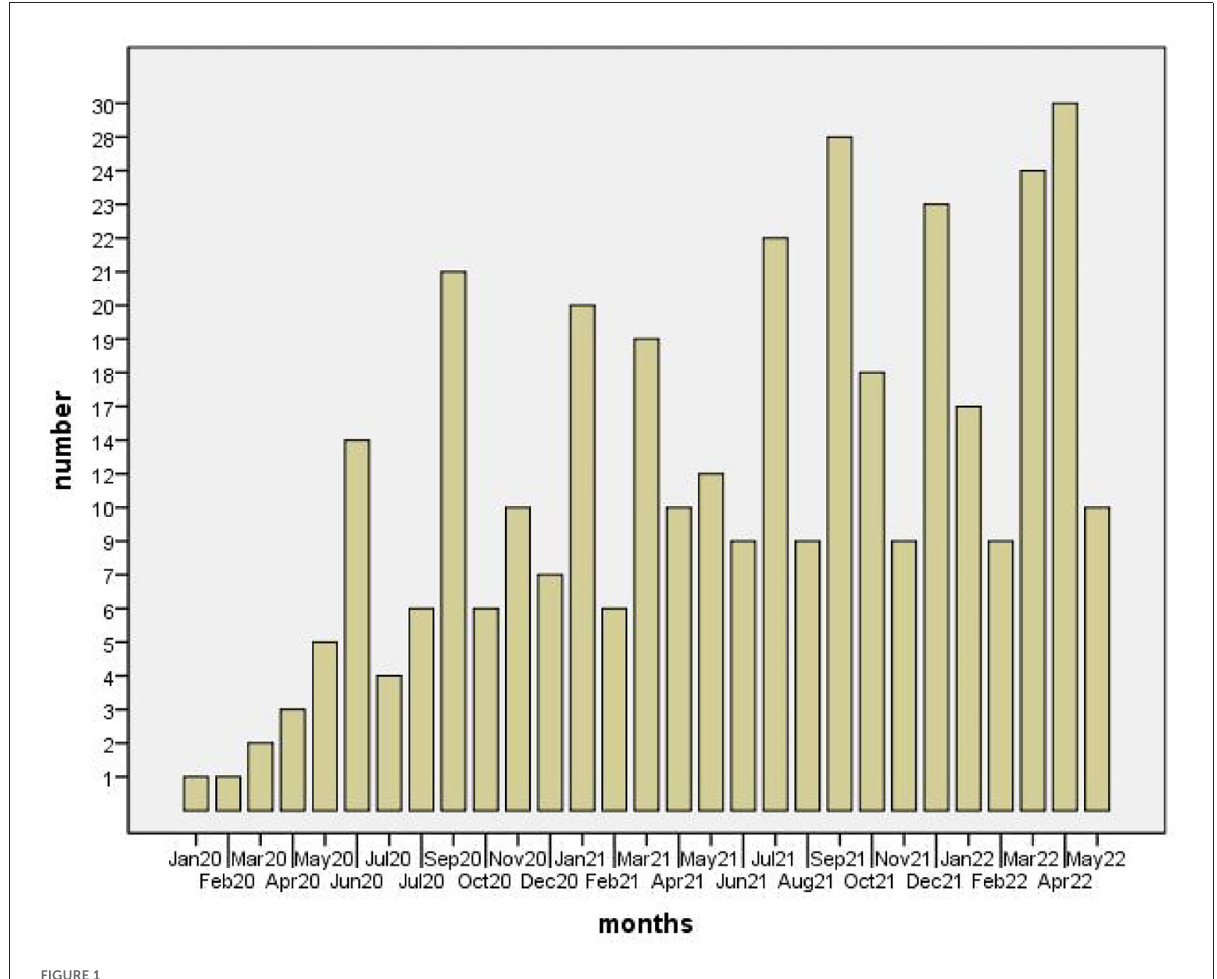
FIGURE1 Number of articles published by